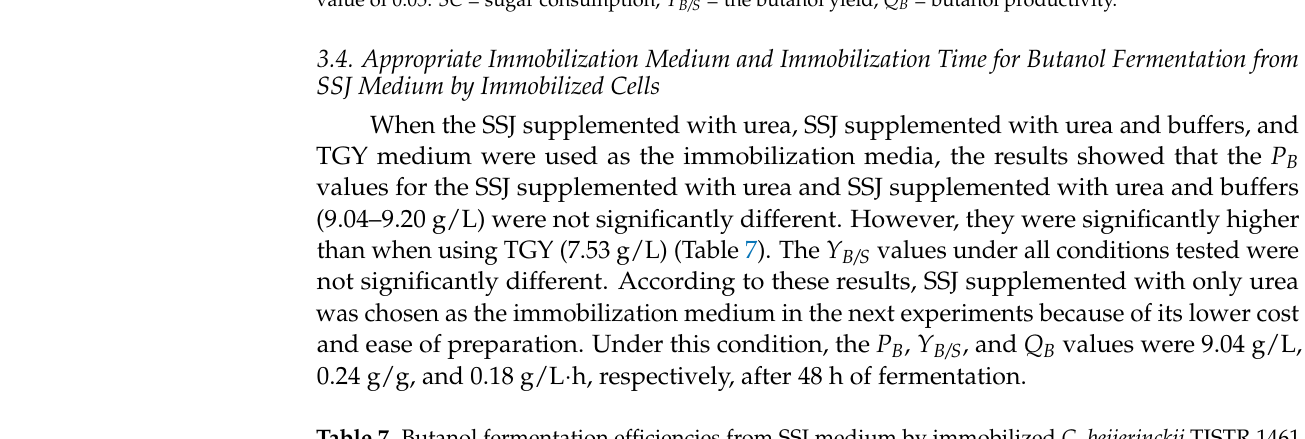
Table 6. Batch butanol fermentation efficiency levels with immobilized C. beijerinckii TISTR 1461 on